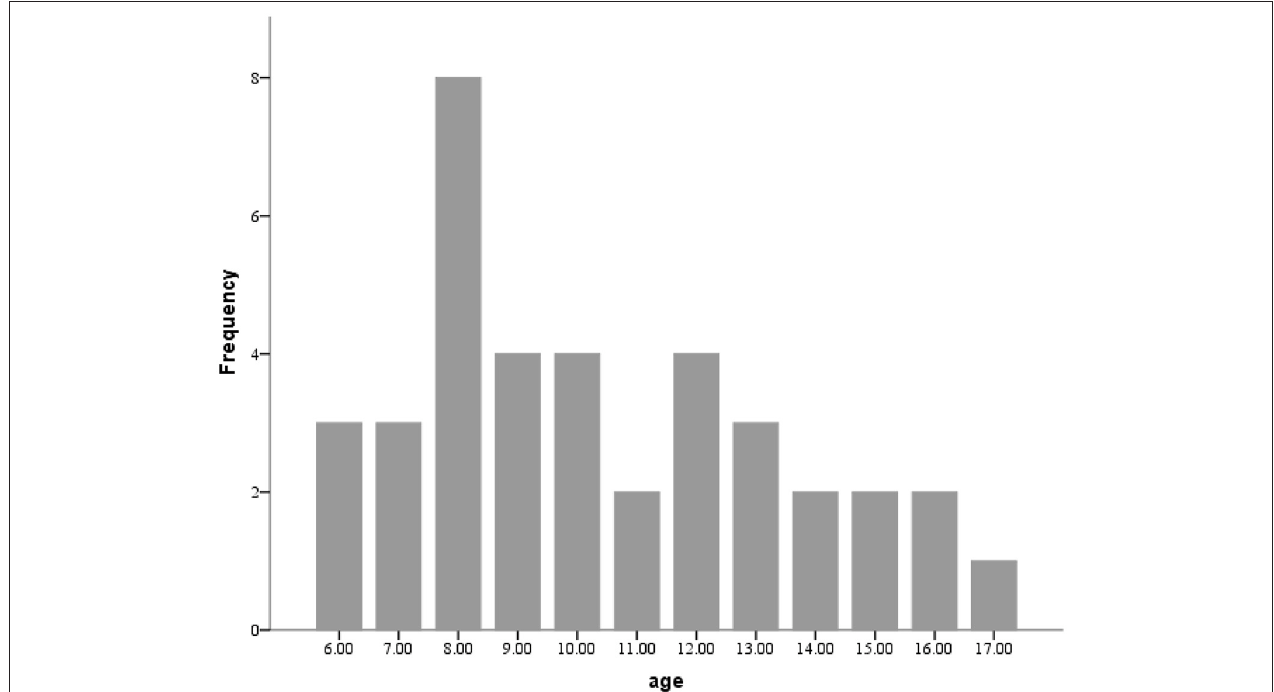
FIGURE 1 | Age distribution of